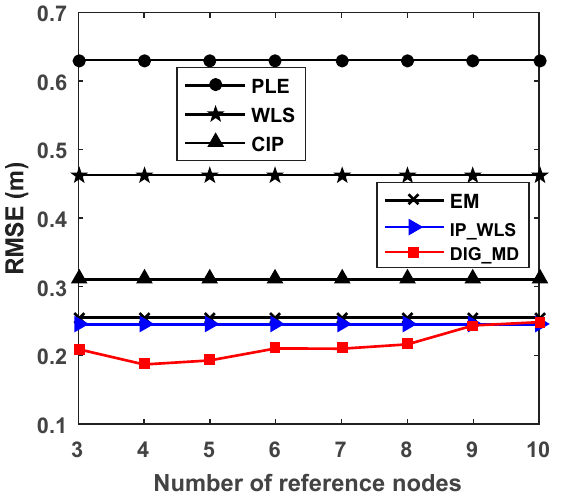
Figure 12. RMSEs for different numbers of reference nodes.